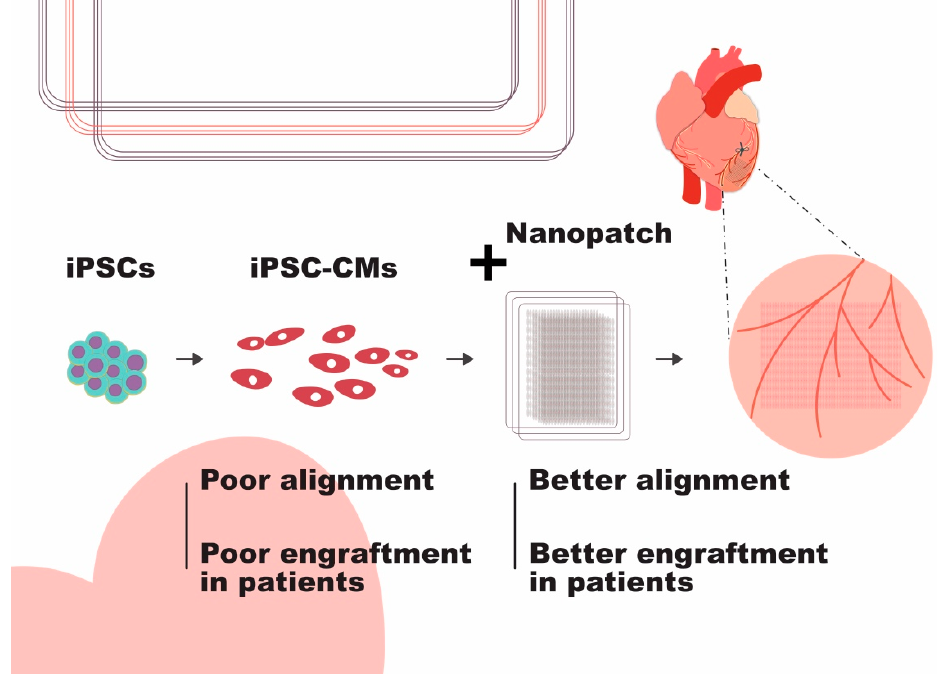
Figure 3. Engraftment of pluripotent stem cell-derived cardiomyocytes can be improved by attachment to a cell sheet. On their own, poor alignment and engraftment are the main issues. However, attaching them to a nanopatch results in better cardiomyocyte alignment and, ultimately, better engraftment in patients.